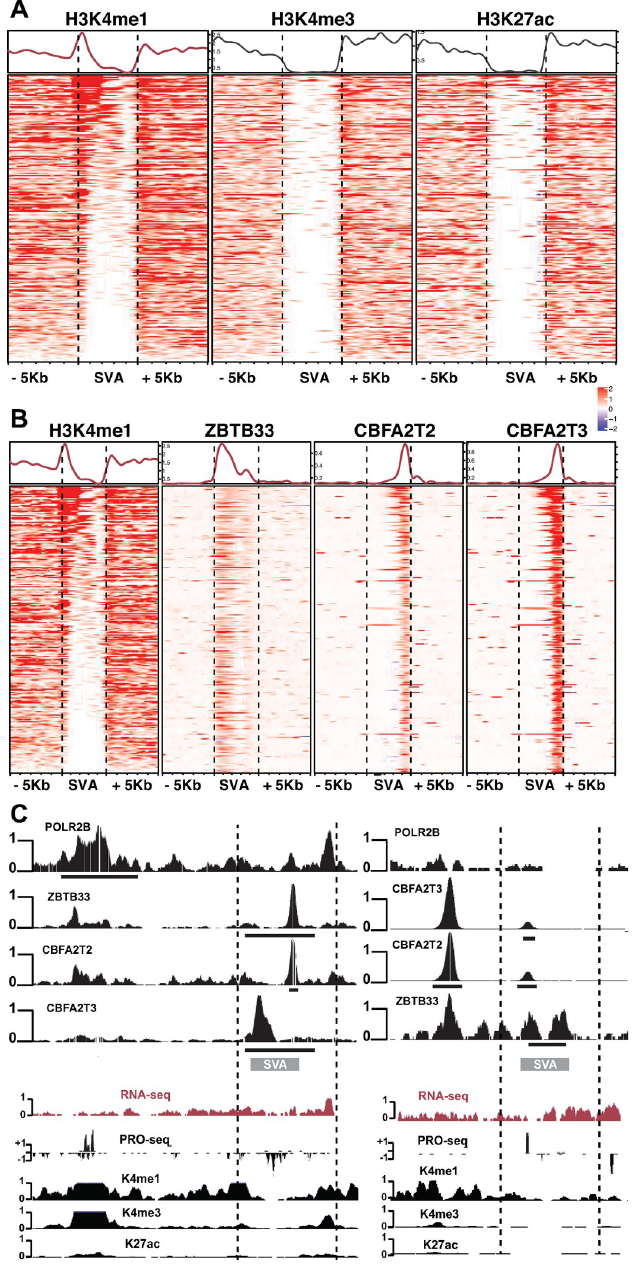
Fig 5. Human SVA repeats are enriched for DBPs and enhancer properties. (A) Heatmap of histone modification reads centered on SVA and 5Kb up- and down-stream for the 255 SVA elements containing ZBTB33 and CBFA2T2/ T3 peaks. Here red indicates enrichment, while blue indicates depletion. Above is the average profile line of enrichment within and outside SVA elements. (B) Same as (A) but coverage of ZBTB33 and CBFA2T2/3T3. The H3K4me1 plot is same as in (A) for direct comparison. (C) Browser examples in the same format as Fig 1. across replicates and quantified by transcripts per million reads (TPM); while considering the variance between replicates in further analyses. We first asked if the number of binding events at a promoter correlated with expression. We observed a positive correlation (R = 0.6,